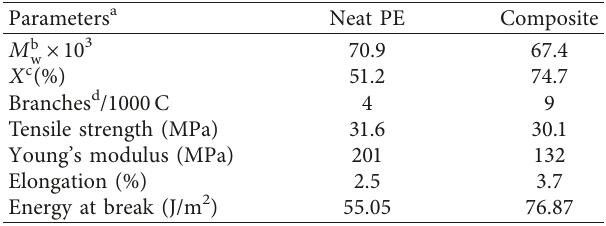
Table 1: Mechanical properties of PE and PE/MWCNT nanocomposite.